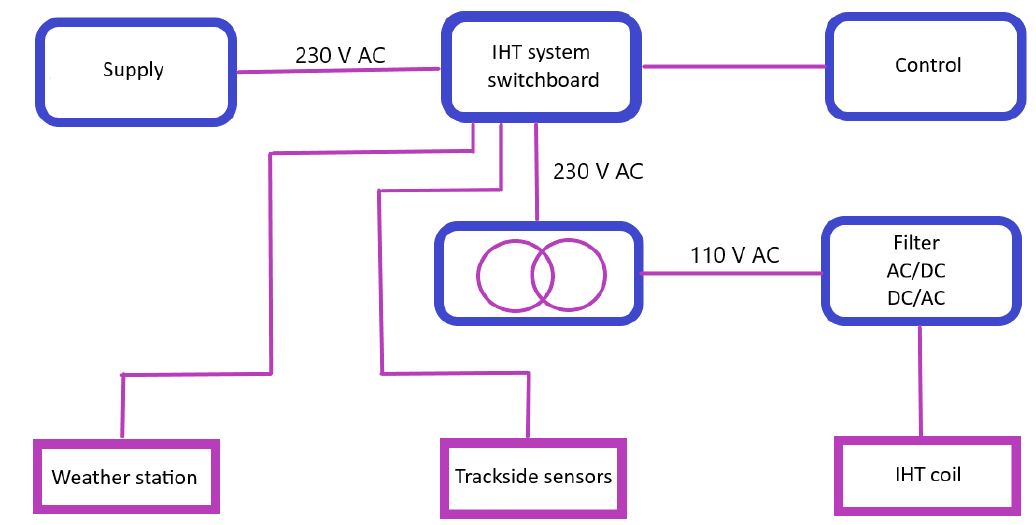
Figure 3. Elements of system for inductive heating of turnouts (IHT).